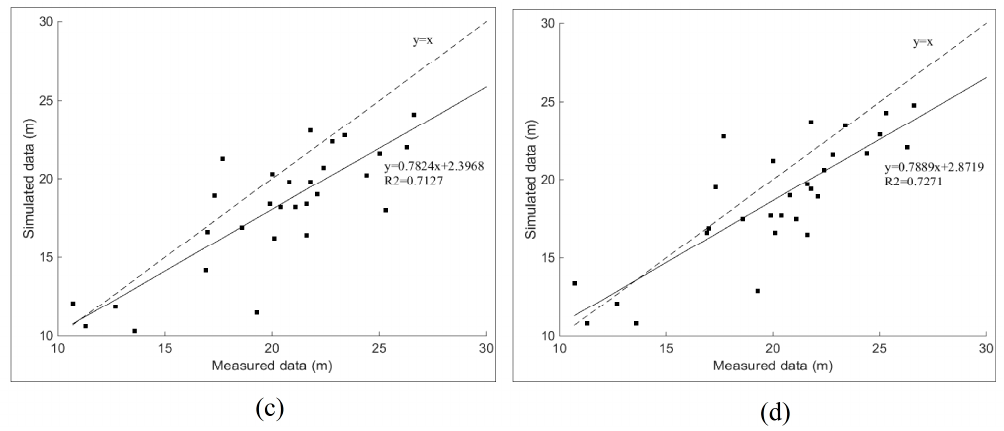
Figure 5. Relationship between the measured and simulated plot-level maximum tree heights for the 30 plots. ( a ) Mean filter; ( b ) median filter; ( c ) HPM; and ( d ) our method.